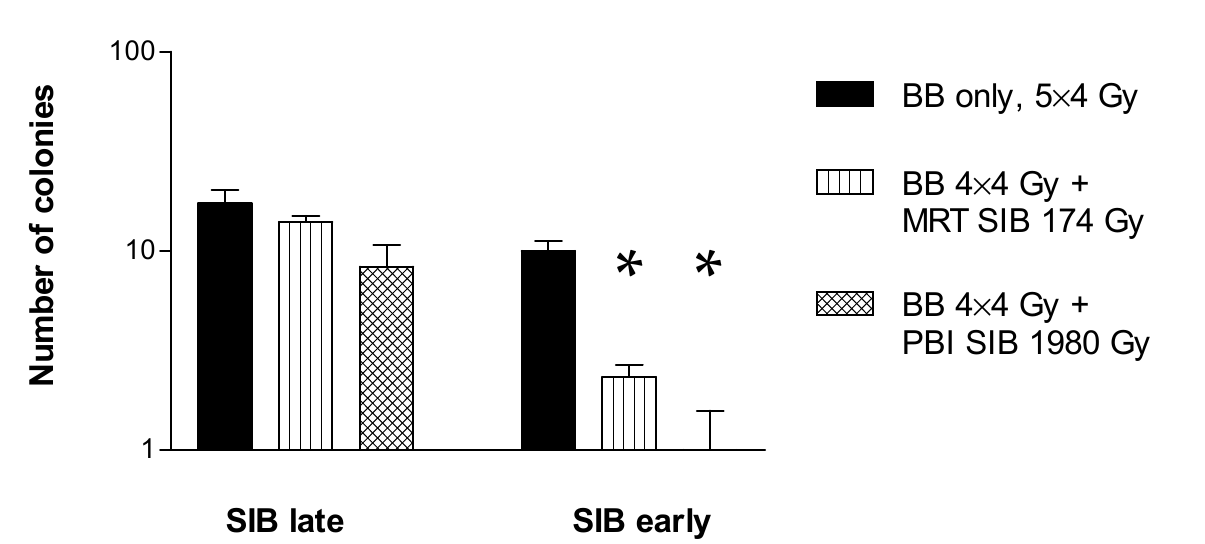
Figure 6. Colony counts after low dose rate irradiation with and without SIB. Only a small additional decrease in the number of colony counts was seen after the late SIB, but a highly significant additional decrease was achieved with an early spatially fractionated high dose rate SIB, compared to low the dose rate irradiation alone. The difference between the monoplanar MRT SIB and PBI SIB was also statistically significant. The cells were irradiated in the flasks directly. Error bars represent SEM. Asterisks are used to highlight statistically significant differences compared to the other two groups in the early SIB experiment.